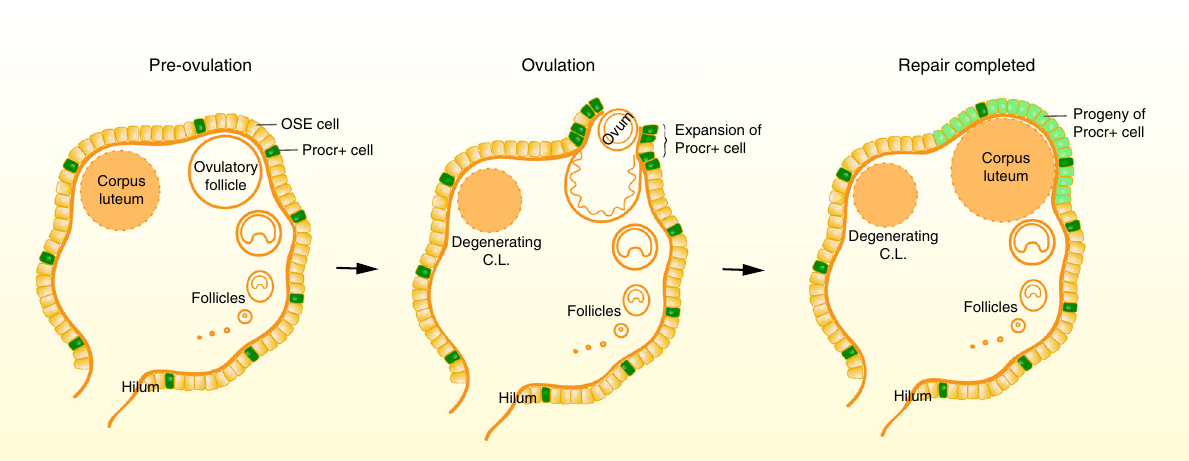
Fig. 7 Proposed model of Procr + progenitor cell activity during ovulatory rupture repair. Procr + progenitor cells (dark green) are distributed in all regions of the ovarian surface (beige). Upon ovulation, Procr + progenitors near the rupture site expand immediately, facilitating rapid expansion of progeny cells. When repair is completed, Procr + cells return to their original numbers that are required for their role in maintaining homeostasis. During the process, the progeny of Procr + progenitors (light green) are the major contributors for replenishing the